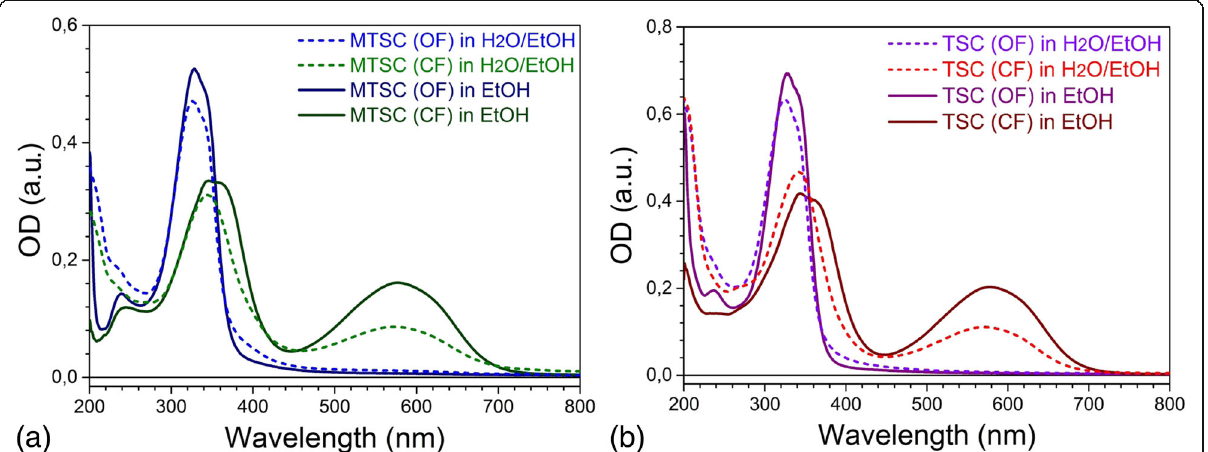
Fig. 2 The photoinduced transformations between OF and CF represented in absorbance spectra of a C5F-MTSC and b C5F-TSC solved in ethanol and water-ethanol solutions, C DAE = 10 − 5